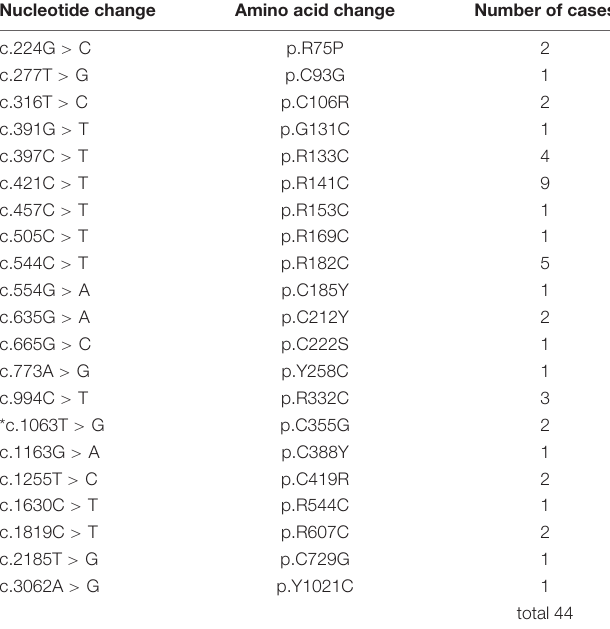
TABLE 2 | Summary of NOTCH3 mutations.